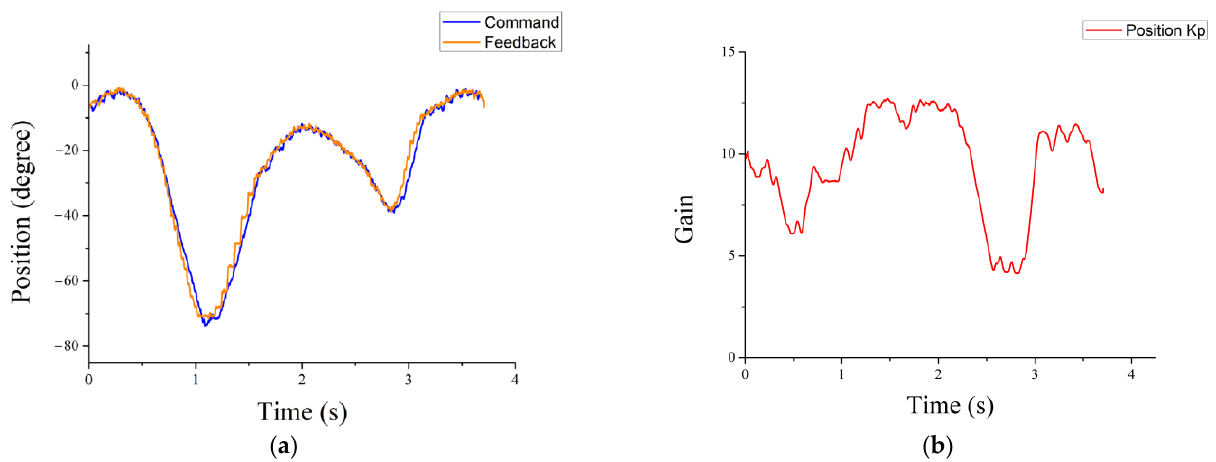
Figure 22. ( a ) Tracking performance of the knee by the self-tuning controller; ( b ) controller gains of the knee by the self-tuning controller.